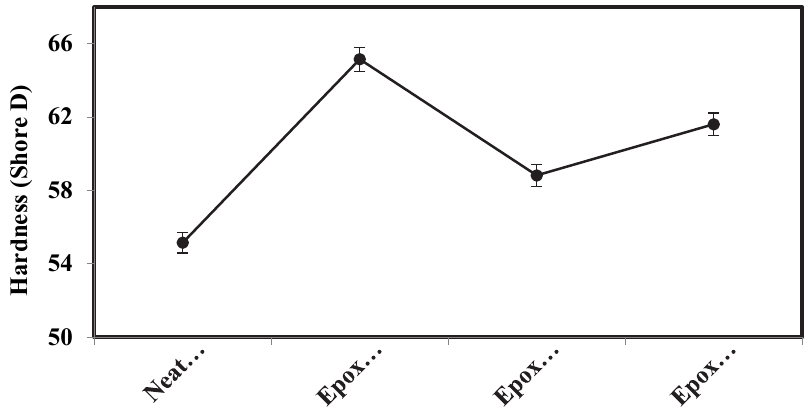
Figure 3: Hardness values of composites with different types of fillers.